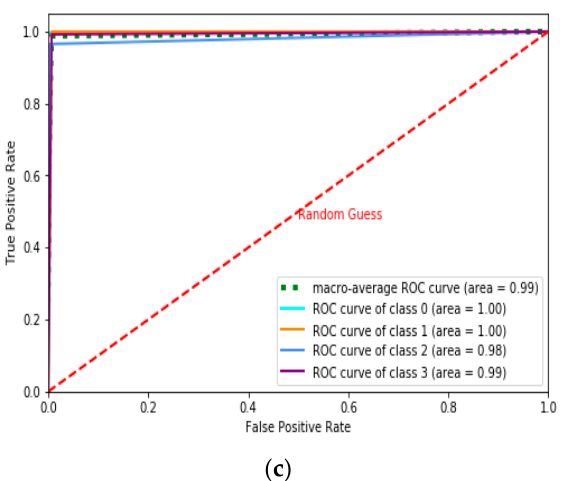
Figure 3. Multiclass AUC-ROC curve for MultiLayer Perceptron (MLP) model with three hidden layers for: ( a ) N h = 30, ( b ) N h = 50, ( c ) N h = 80.